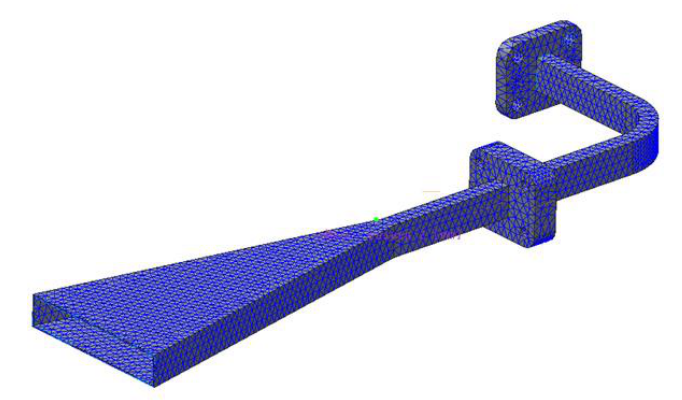
Fig. 3. Polygonal models of a waveguide transition with H-sectorial horn.